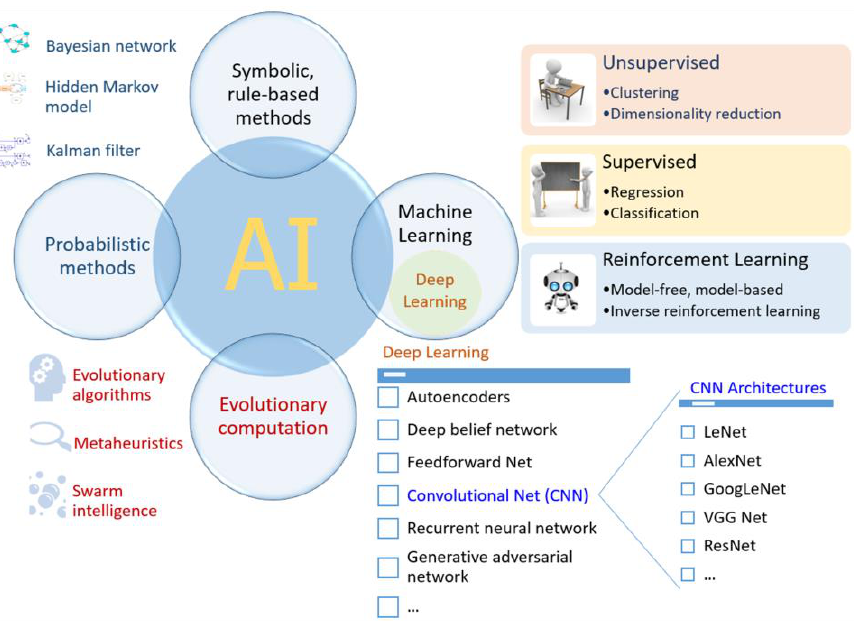
Figure 27. An overview of common AI methods where machine learning constitutes a key ingredient. The development of deep learning, a subset of machine learning, has contributed significantly to improving the power and capability of recent AI applications. A number of deep learning-based convolutional neural network (CNN) architectures, e.g., LeNet, AlexNet, GoogLeNet, Visual Geometry Group (VGG) Net and ResNet, have been proposed and applied successfully in different domain, especially in the computer vision. Other techniques such as autoencoders and recurrent neural networks are crucial components of many prominent natural language processing tools. The deep learning methods in particular, and AI in general, may thus be employed to create useful applications to deal with various aspects of the COVID-19 pandemic [105]. Abbreviations used: AI, Artificial